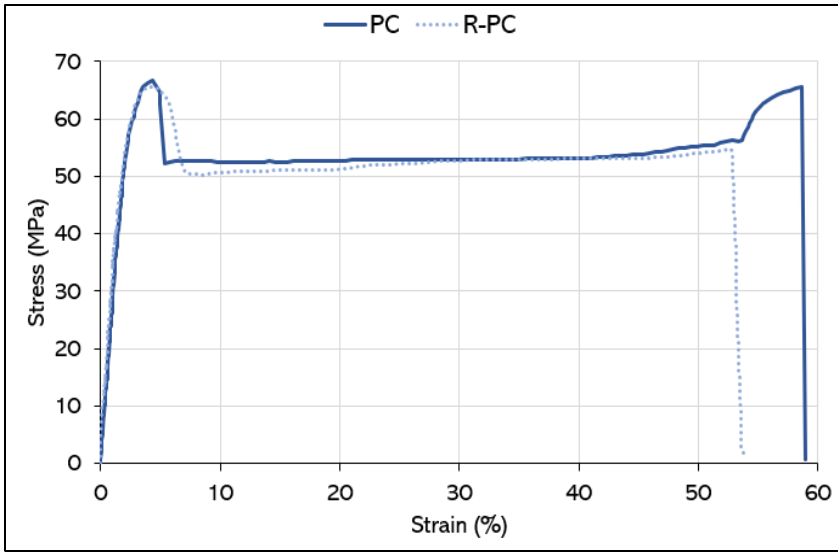
Figure 4. Stress/strain curves for PC and R-PC.